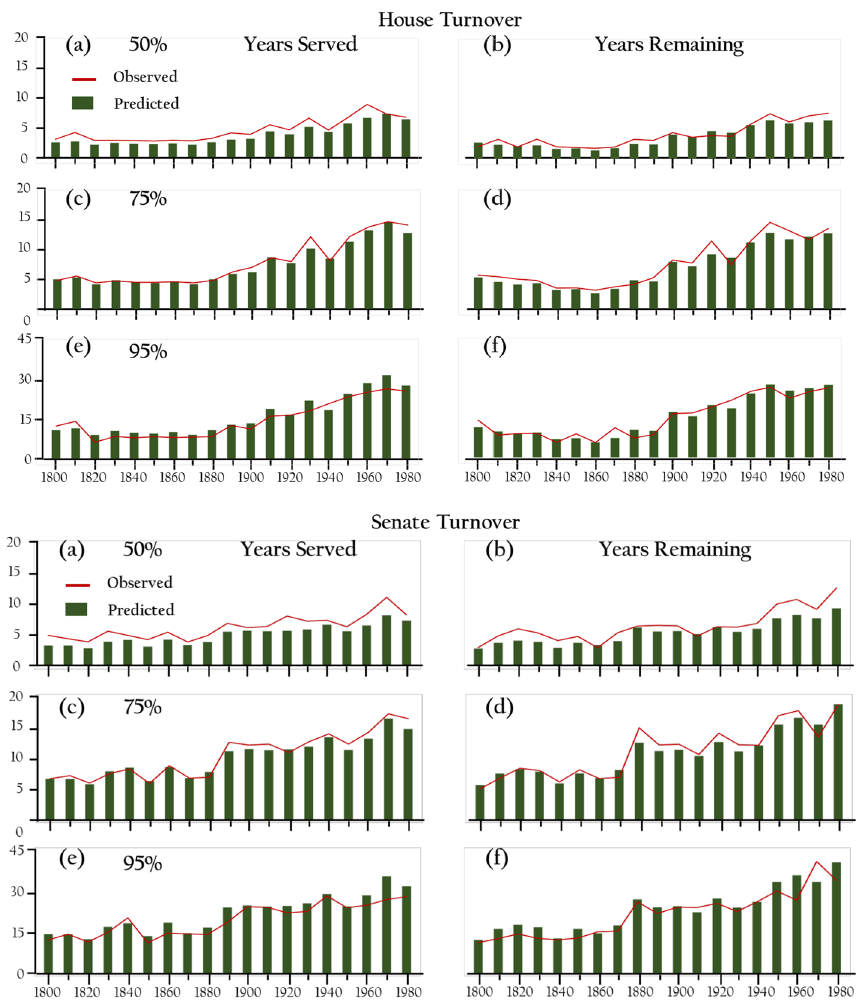
Fig. 7 Number of years required for 50, 75 and 95% turnovers in the U.S. House (top set of panels) and Senate (bottom set of panels) in 10-year intervals from 1800 through 1980 for years served (left columns) and years remaining (right columns). Bars indicate number of years predicted from exponential model using the inverse of the mean of the distributions for the rate parameter. The red line indicates the actual mean number of years actually served in the Congress during the specified year. Note the different Y -axis scale for the 95%